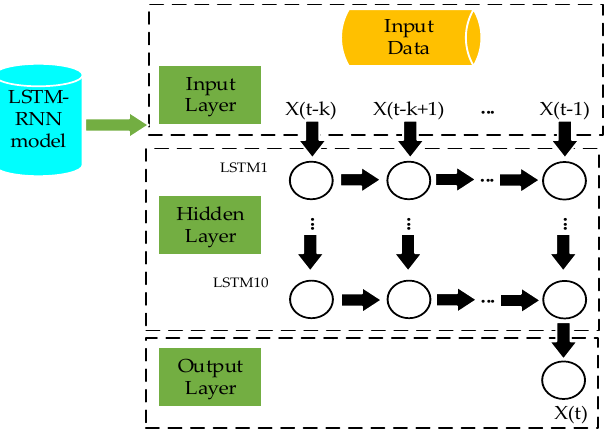
Figure 5. The structure of LSTM-RNN algorithm.